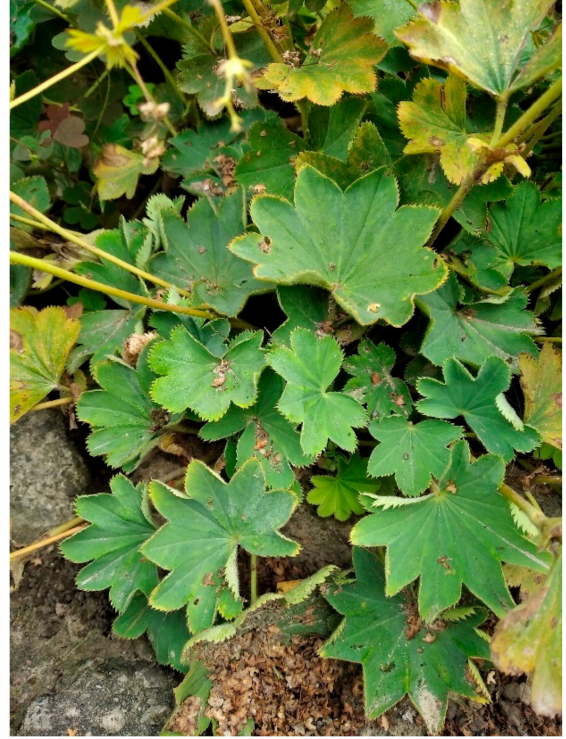
Figure 1. Alchemilla peristerica Pawł. aerial